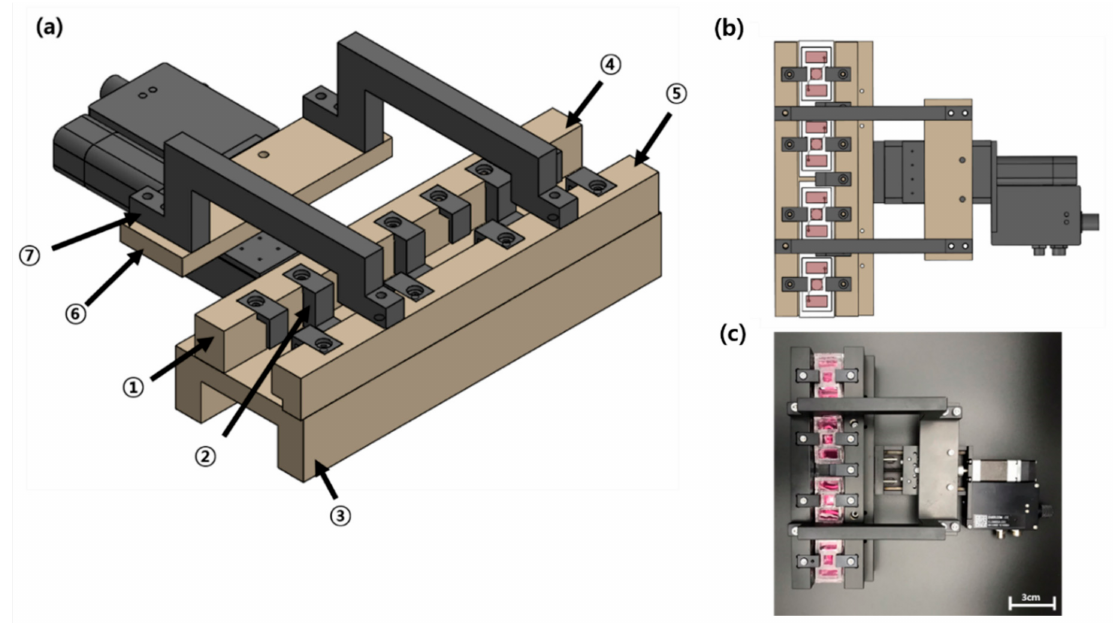
Figure 11. Schematic diagrams ( a , b ) and actual photograph ( c ) of the mechanical stimulus actuating system: 1 (cid:13) Rack, 2 (cid:13) Suspension, 3 (cid:13) Bottom plate, 4 (cid:13) Fixed top plate, 5 (cid:13) Moving top plate, 6 (cid:13) Bridge plate, 7 (cid:13)